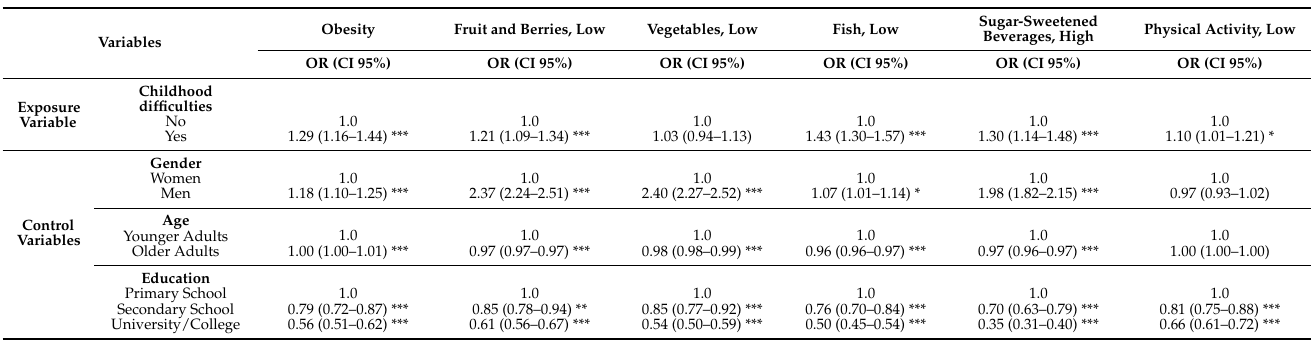
Table 3. Adjusted odds ratio (OR) and 95% confidence interval (CI) for being overweight or obese and having unhealthy dietary habits and low physical activity level in relation to self-perceived childhood